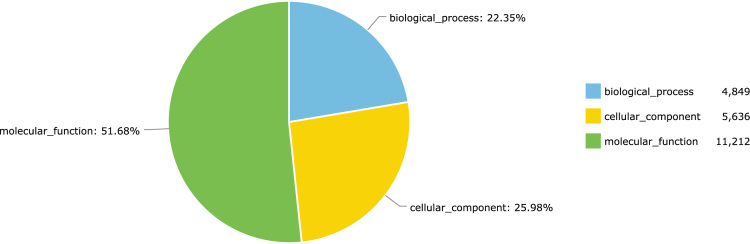
Groups of ontology.